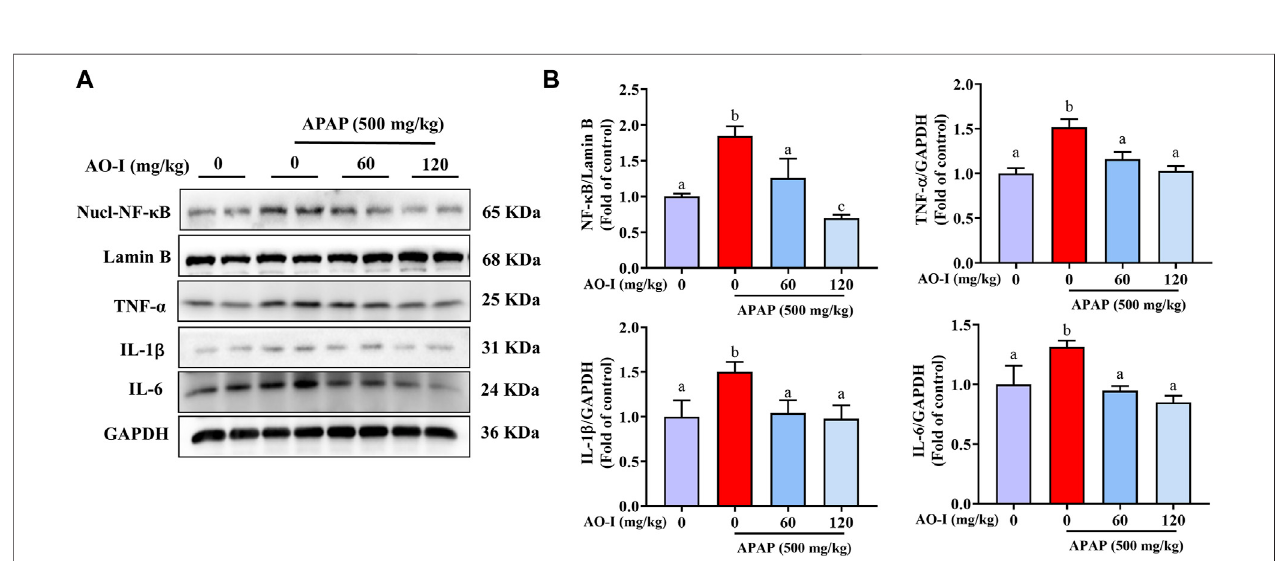
FIGURE2| AO-I inhibitsAPAP-inducedgeneexpression ofin fl ammatoryfactors. Geneexpression levelof (A) IL-1B , (B) IL-6 and (C) TNFA .Alldataarepresented as the mean ± SEM. Bars with different characters present statistically signi fi cant results, p < 0.05.